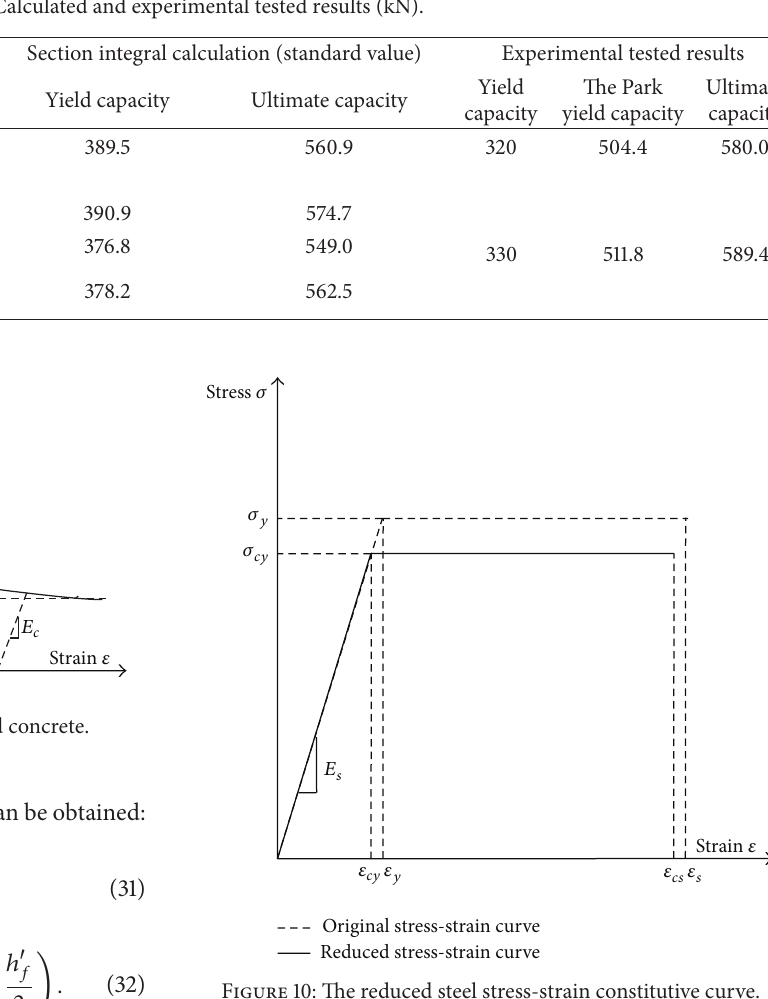
Figure 10: The reduced steel stress-strain constitutive